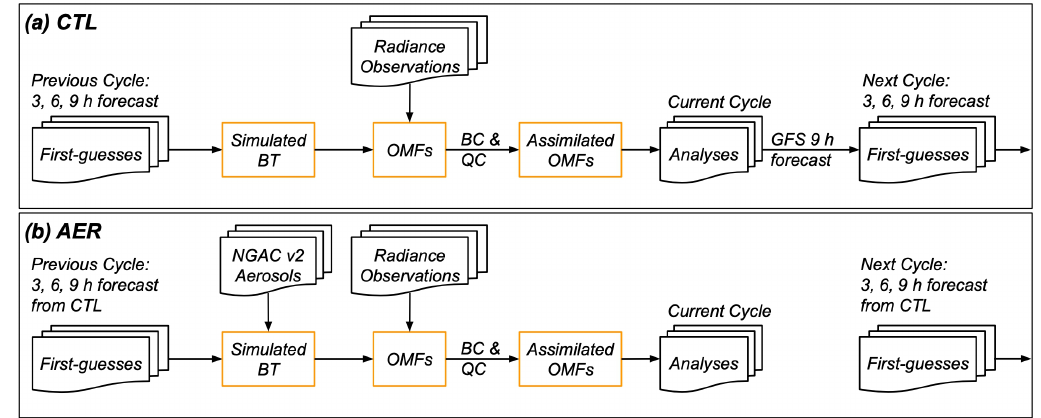
Figure 1. The diagram of the procedures for radiance observations in an analysis cycle of GSI. ( a ) is the aerosol-blind cycling experiment (CTL). ( b ) is the aerosol-aware offline experiment (AER). The orange boxes indicate the data processed in the GSI.